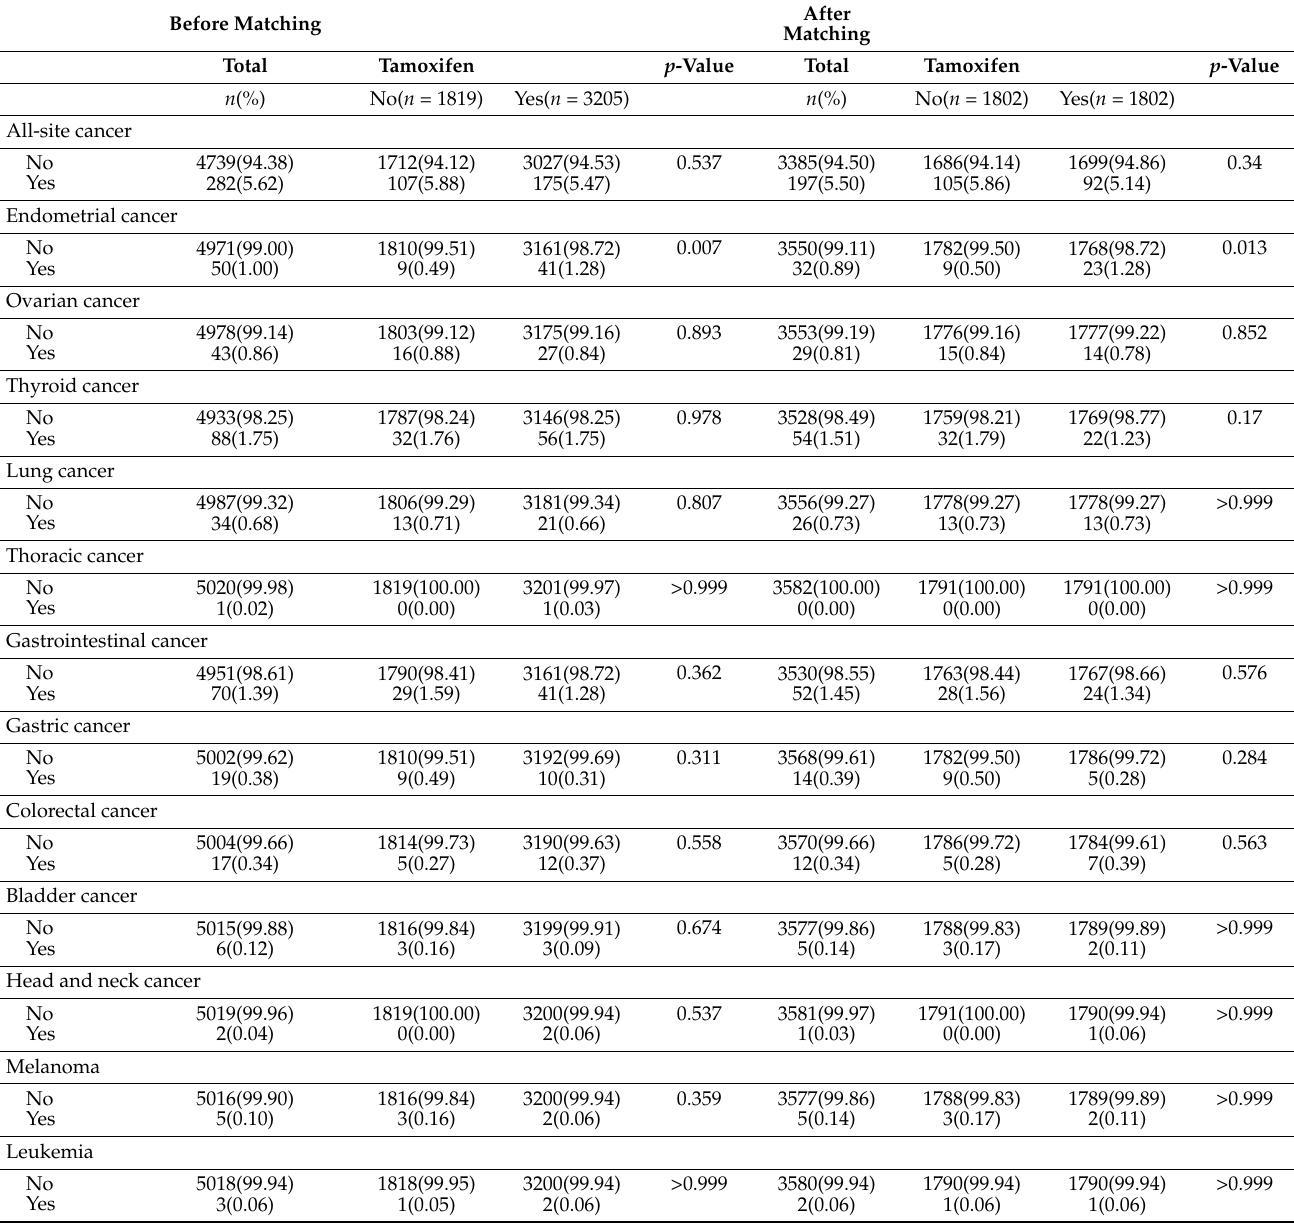
Table 1. Demographics and incidence of secondary cancer according to long-term tamoxifen